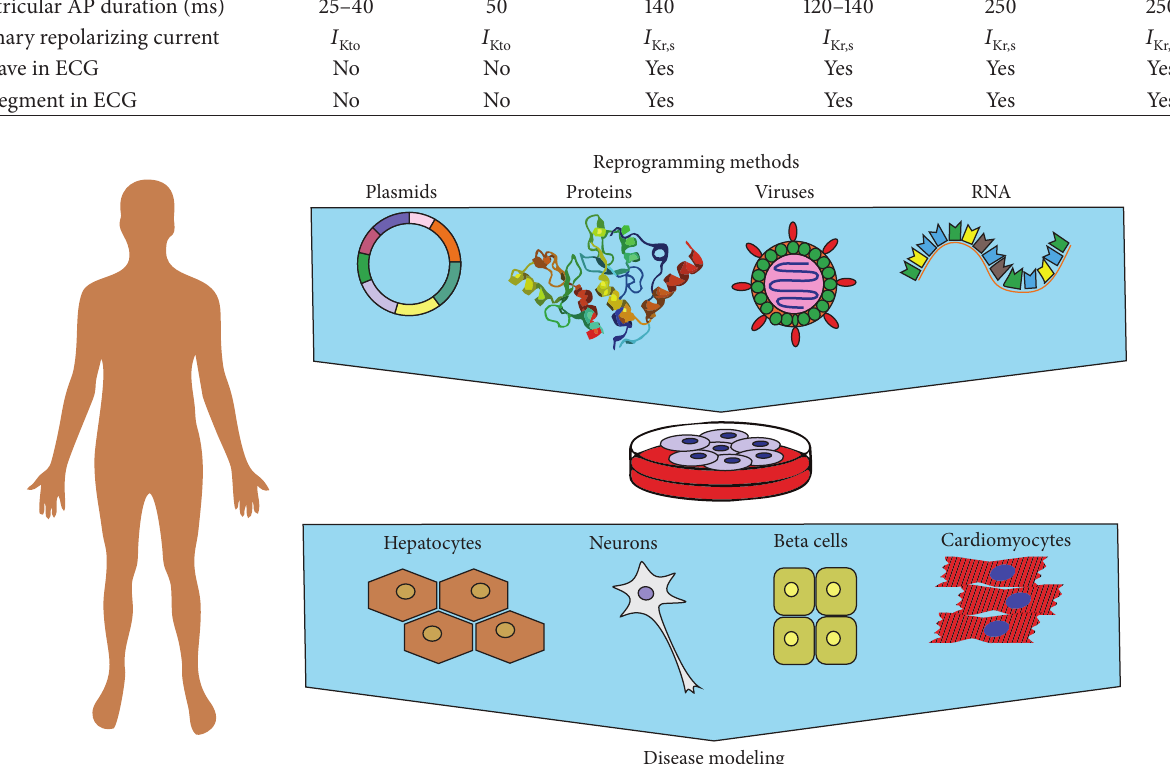
Figure 1: Induced pluripotent stem cell-based approach for human disease modeling. hiPSCs can be generated from human somatic cells using viruses, plasmids, modified RNA, and recombinant proteins. iPSCs are differentiated into various cell types for disease modeling, drug screening, and cell